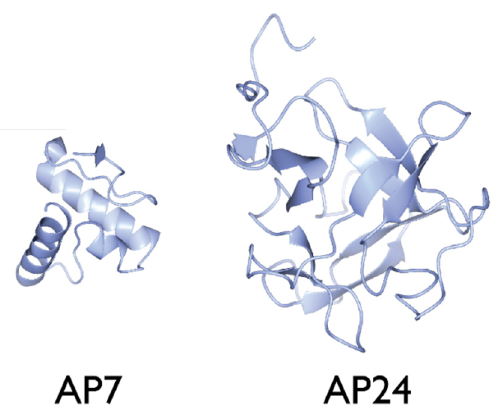
Figure 3. INTFOLD-predicted three-dimensional structures of H. rufescens AP7 and AP24 proteins, in ribbon representation. The protocol for structure prediction is provided in [27]. AP24 is represented without glycan groups. Note that each protein has surface-accessible domains or regions which could serve as sites for protein–protein interaction.